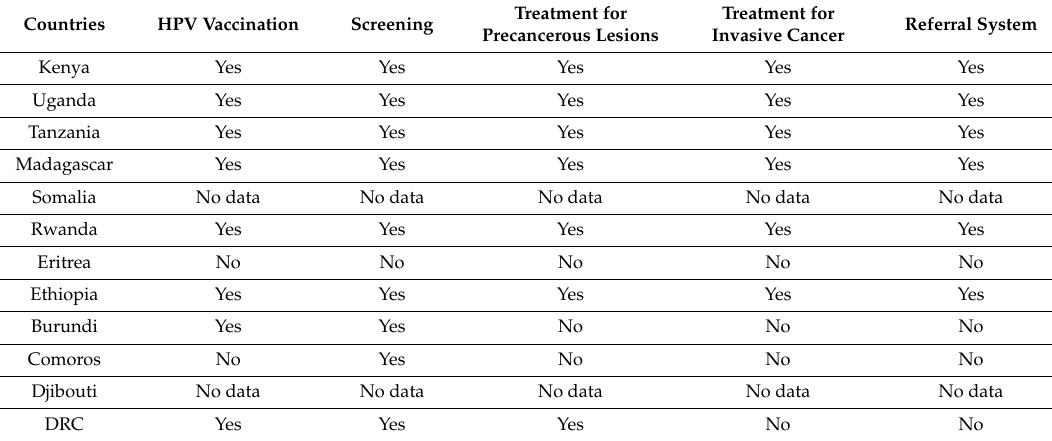
Legend: This table demonstrates how the cervical cancer legal documents from the di ff erent countries had adhered to five essential requirements by the WHO Comprehensive Cervical Cancer Control guide to essential practice [7]. Yes means that the legal documents in a country fulfilled the essential elements, No means lack of information in the national legal documents, while no data means lack of any relevant legal documents from a